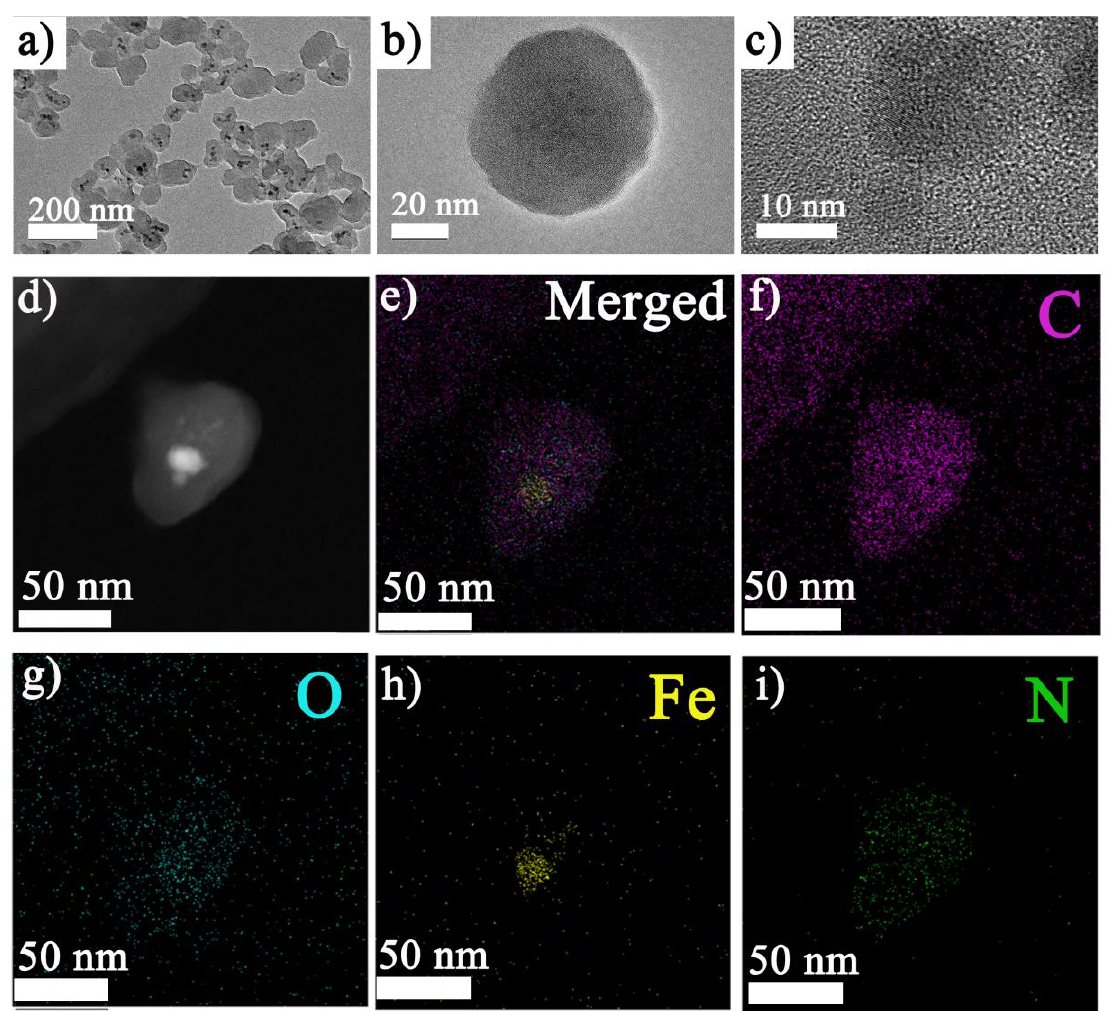
Figure 1. Morphology and elemental analysis of graphene quantum dots (GQDs) loaded nanoparticles: ( a ~ c ) high resolution tranmission electron microscopy (HRTEM) images at di ff erent magnifications (bright field image); ( d ~ i ) energy dispersive spectroscopy (EDS) analysis of the nanocomposite; ( d ) graph representation, ( e ) EDS analysis of the nanocomposite (merged), ( f ) EDS C elemental map, ( g ) EDS O elemental map, ( h ) EDS Fe elemental map, ( i ) EDS N elemental